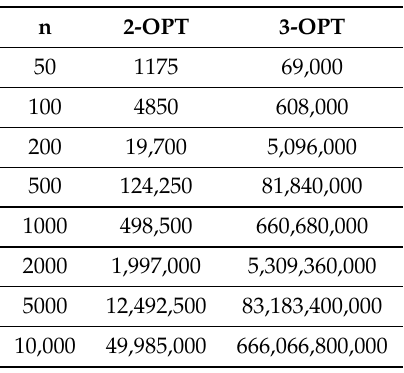
Table 1. The number of true 2-OPT and 3-OPT moves for some n . n 2-OPT